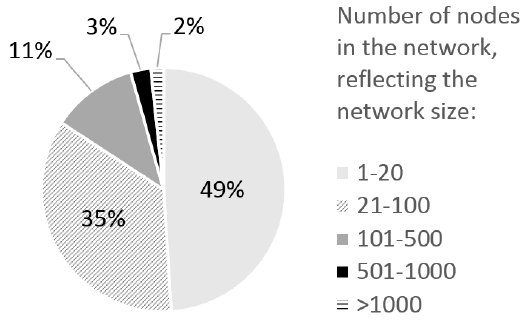
Figure 5. Test networks (of papers from the appendix table) by network size.